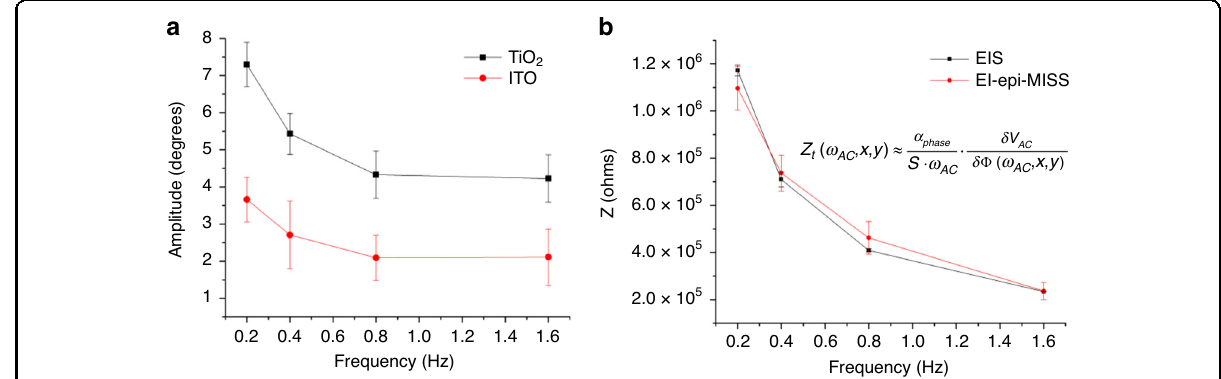
Fig. 4 Surface electrical contrasts. a The amplitude of the optical phase modulation averaged for multiple speci fi c areas on the surfaces corresponding to holes and the TiO 2 coating vs. the electrical actuation frequency. b Average TiO 2 impedance measured by both EIS and el-epi-MISS (Z t ( ω AC , x , y ))